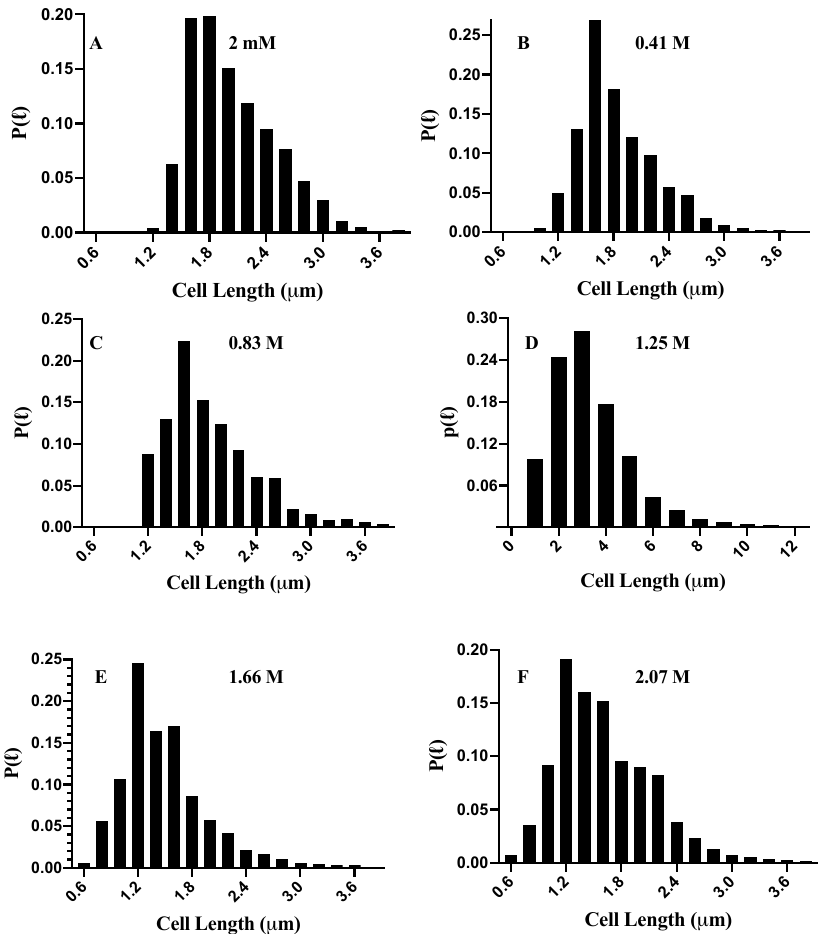
Figure 3. Probability distribution, P ( (cid:96) ) , of cell length of E. coli at MgSO 4 concentrations of ( A ) 2 mM, ( B ) 0.41 M, ( C ) 0.83 M, ( D ) 1.25 M, ( E ) 1.66 M, and ( F ) 2.07 M, respectively. The x -axis range is the same for all the panels except panel D. For salt concentrations ≤ 0.83 M, the probability distributions are similar but shift to lower values of length. Cell length exhibits large heterogeneities at 1.25 M of salt concentration, leading to a long-tailed distribution. Note that filamentous cells are counted as single cells. For concentrations >1.25 M, there is cell death, and the probability distribution is over both dead and live